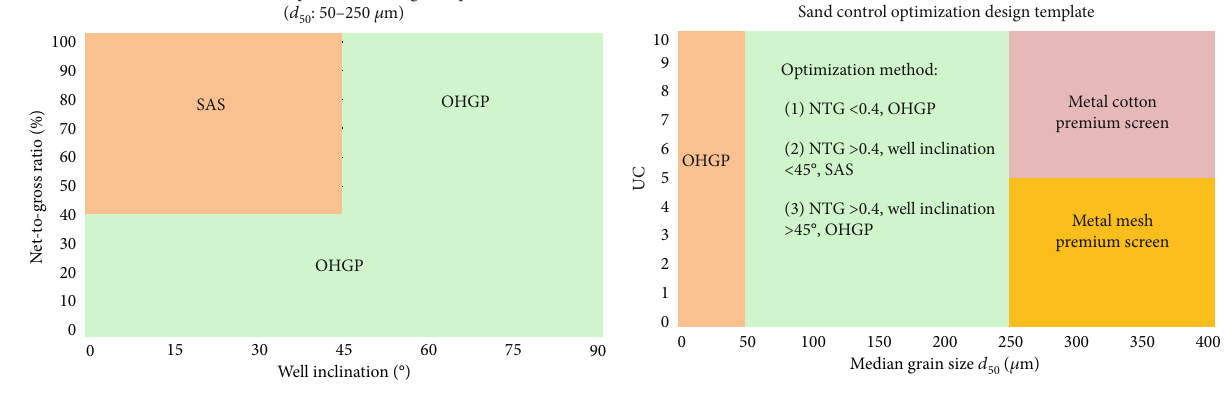
Figure 12: Sand control method for ISMR. Table 4: Reservoir characteristic statistics of the Minghuazhen Formation in the PL oil fi